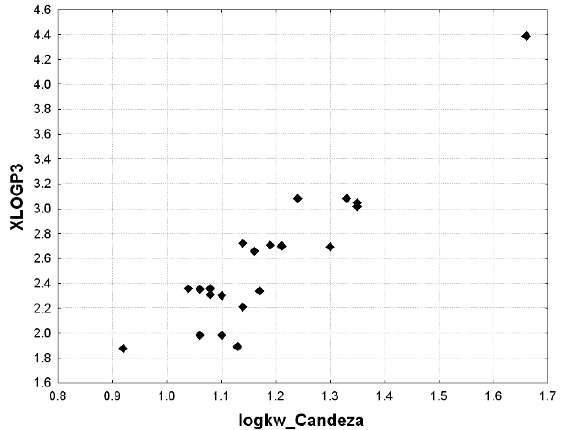
Figure 4. Example of correlation between determined (logkw_Candeza) and calculated lipophilicity (XLOGP3) for acridinones with statistical significance level p = 1×10 -7